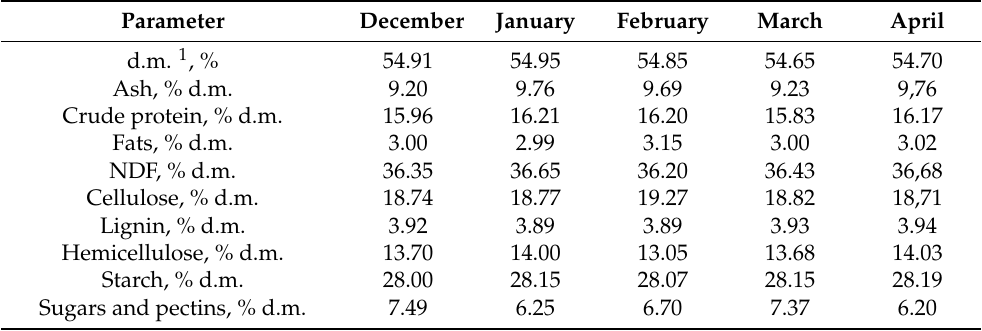
Table 4. Analysis of the composition of the control diet, done with the portable NIR instru- ment Polispec.